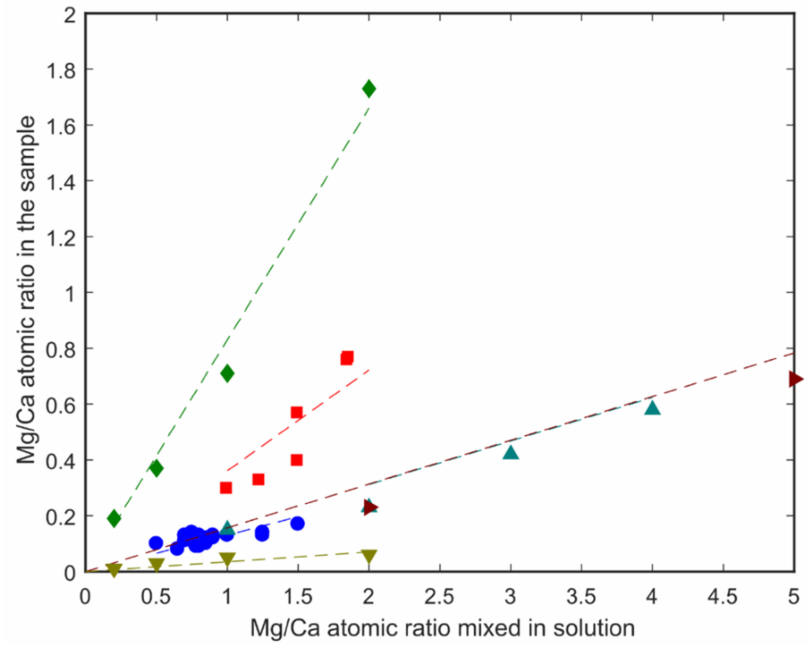
Figure 1. Comparison of Mg/Ca ratios measured in ACC samples to Mg/Ca ratios of the solutions from which they formed for samples: with water [33]; the dashed lines are linear fits to the data points of corresponding